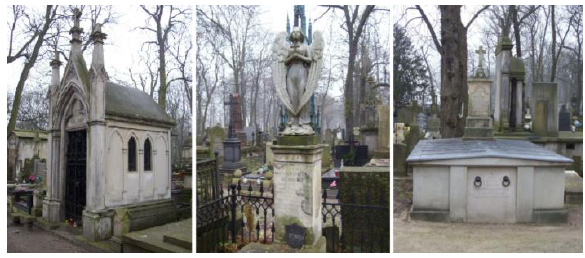
Figure 1. Objects selected for the research